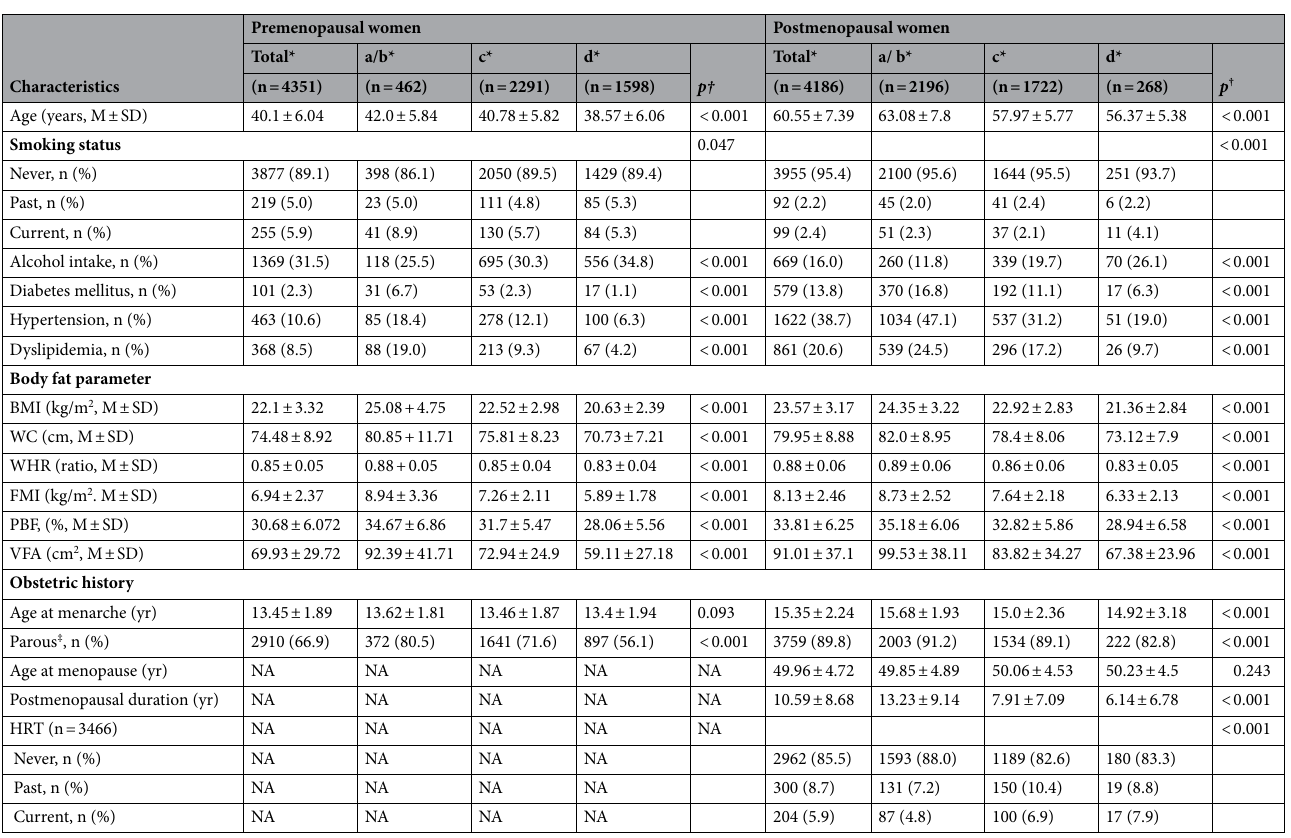
Table 1. Baseline characteristics according to grade of breast density in premenopausal and postmenopausal women. Values are presented as mean (M) + standard deviation (SD) for continuous variables or n (%) for categorical variables. *a, b, c, and d mean grades of mammographic breast density according to BI-RADS in premenopausal and postmenopausal women and Total is number of total cases in both groups. † p values